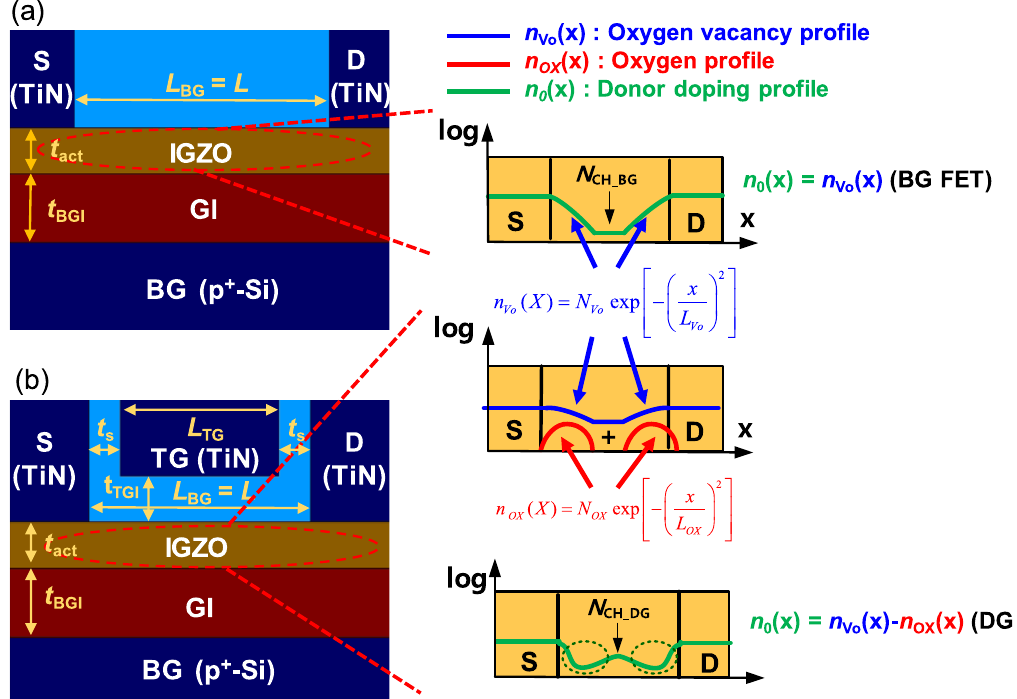
Figure 4. Models for n Vo ( x ) and n 0 ( x ) considering the device structure and process conditions, which are implemented by the TCAD device simulator for the ( a ) BG FET and the ( b ) DG FET